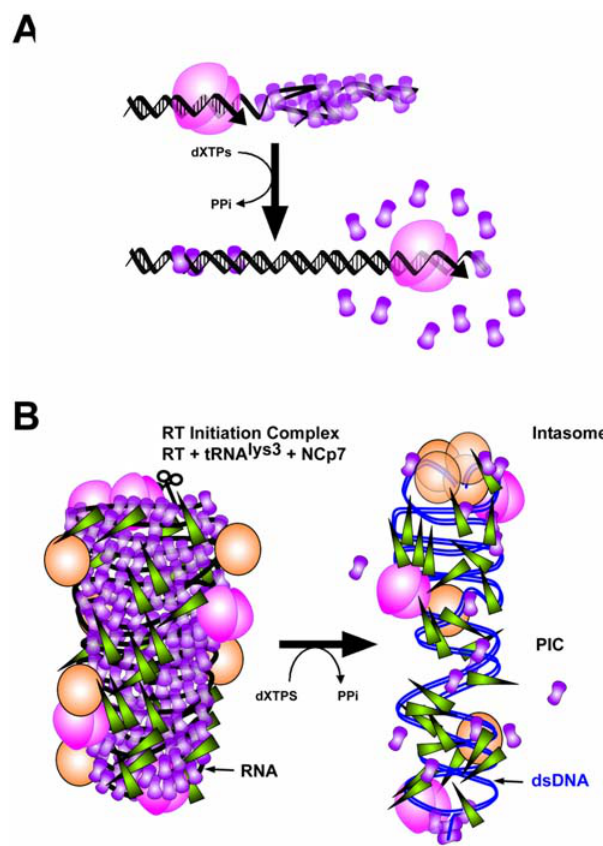
Figure 6. Hypothetical model for HIV-1 nucleocapsid dismantling controlled by RT directed dsDNA synthesis. (A) translocation of RT on a minus DNA template coated with NCp7. RT displaces NCp7 during this translocation reaction while converting ssDNA into dsDNA, which does not allow NCp7 to re-associate in an aggregative mode. The dismantling force is driven by dNTP hydrolysis that allows continuous RT translocation. Magnesium is critical as it weakens dsDNA-binding by NCp7. (B) macroscopic consequence of the NCp7 dismantling activity of RT. A reverse transcription complex is depicted from a perspective of the nucleocapsid architecture used in figure 5. Once reverse transcription is finished, resulting in dsDNA, the aggregative nucleic acid binding mode of NCp7 is drastically reduced, facilitating the binding of Vpr and IN (as well as other available cellular partners) and thus generating a PIC (represented here in a simplified way according to Nermut et al.[27]).